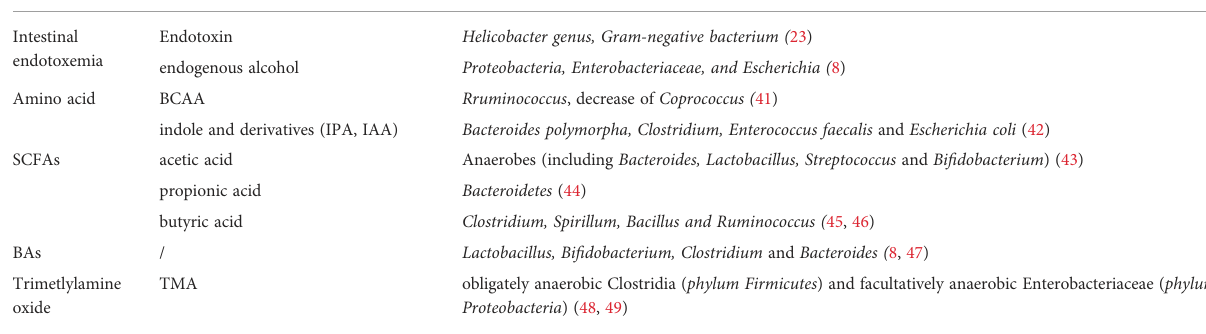
TABLE 1 Metabolite and related fl